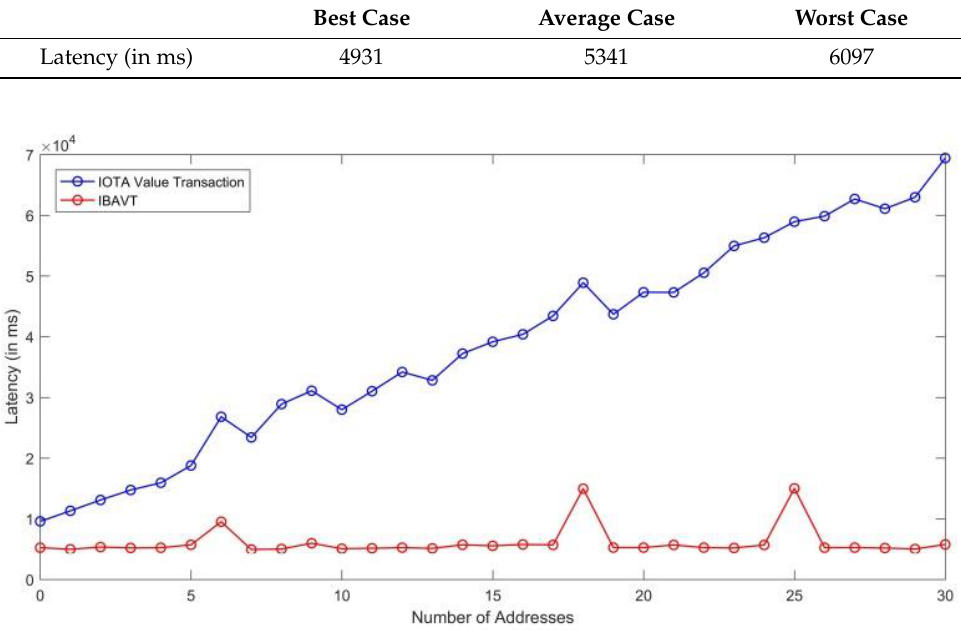
Figure 19. Comparison of latency between our proposed IBAVT and classical IOTA value transac- tions.